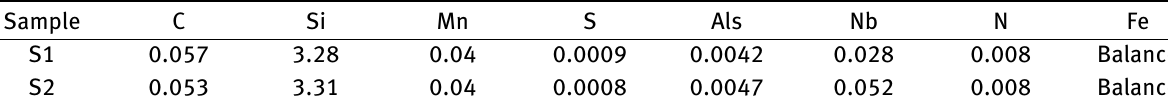
Table 1: Chemical compositions of tested silicon steel (wt%) Sample C Si Mn S Als Nb N Fe